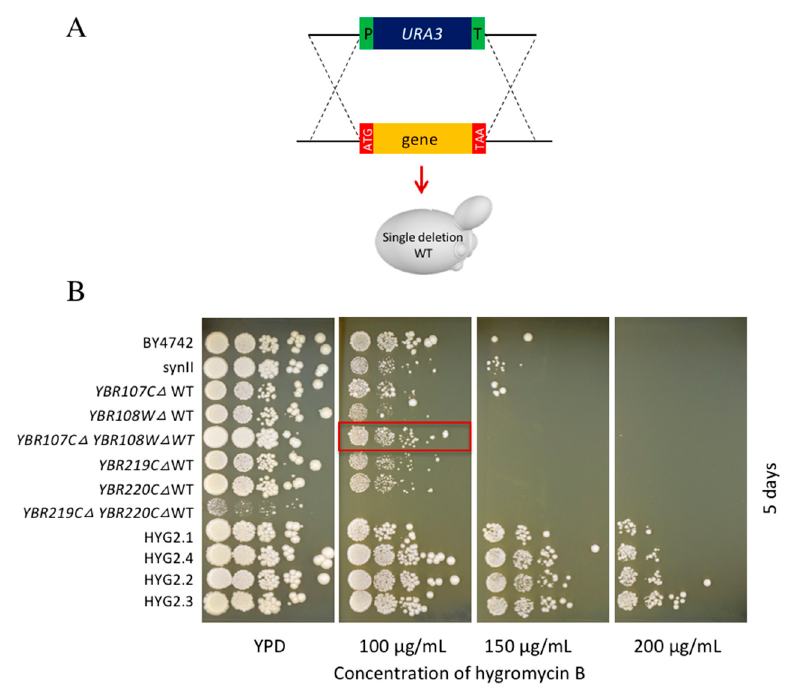
Figure 5. Phenotypic analysis showed that SCRaMbLEd strains are more resistant to hygromycin B compared to single/double deletions strains. ( A ) Visualization of the applied deletion strategy using the endogenous homologous recombination machinery. ( B ) Spot test. BY4742, synII, single knockout, double knockout and SCRaMbLEd strains were spotted on YPD plates containing different concentrations of hygromycin B. Plates were incubated at 30 ℃ and the photos were taken on day 5. The double deletion strain YBR107C ∆ YBR108W ∆ WT grows slightly better compared to the single deletion YBR107C ∆ and YBR108W ∆ strains on the YPD plate +100 μ g/mL hygromycin B. Interestingly, YBR219C ∆ . YBR220C ∆ WT strain has a severe growth defect on the normal growth conditions and it does not improve the resistance phenotype toward hygromycin B.